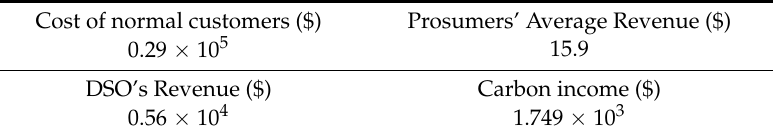
Table 2. Analysis of revenue of entities in a day.